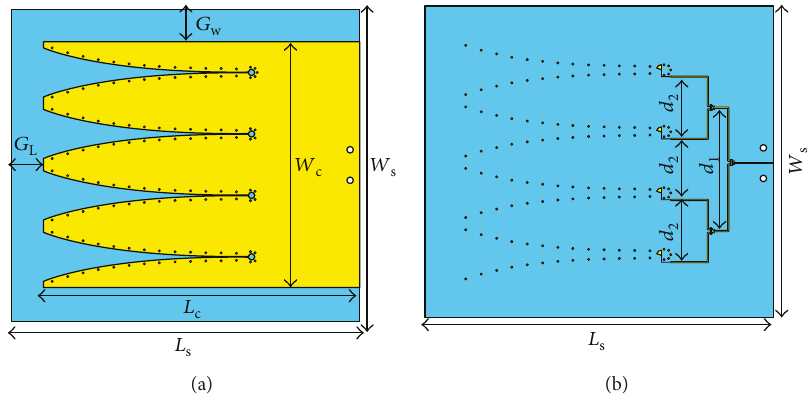
Figure 7: Geometric design of the 1 × 4 linear Vivaldi array antenna. (a) Top plane view and (b) back plane view.